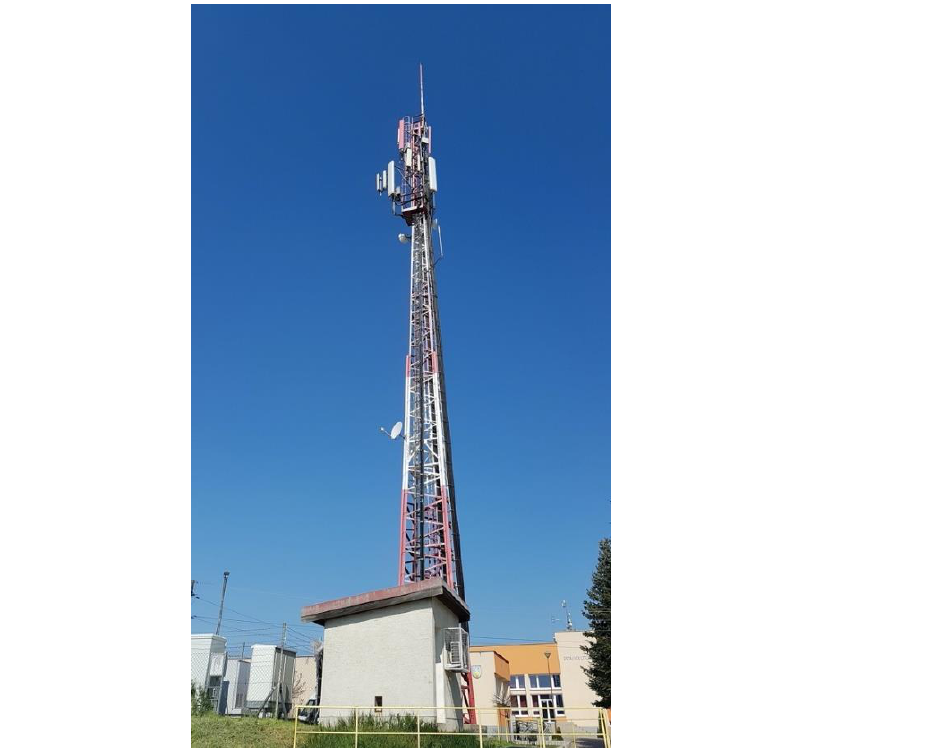
Figure 14. A SmartLNB installed on a communication tower in Slovakia (EUTELSAT 10A coverage).